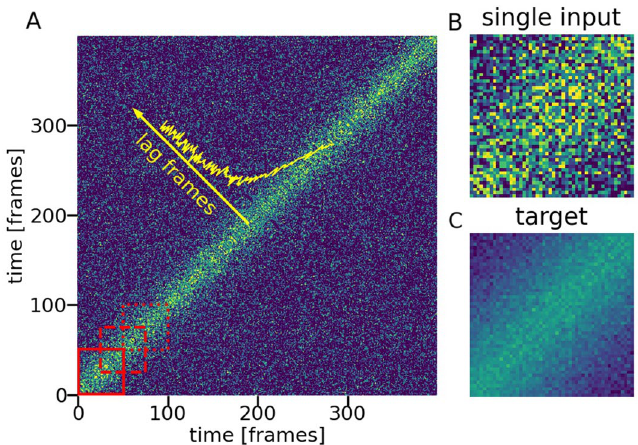
Figure 1. Data for the model. ( A ) 2TCF for an experimental series consisting of 400 frames. Red squares show examples of regions selected for the model training. Yellow arrow shows the temporal direction δt of the system’s dynamics. Yellow solid line shows the 1TCF along δ t , calculated from the 2TCF. ( B ) Example of 50 × 50 2TCF, passed as an input to the model. ( C ) Example of the target data for the model, obtained by averaging multiple 50 × 50 diagonal sections of the 2TCF. All images have the same intensity